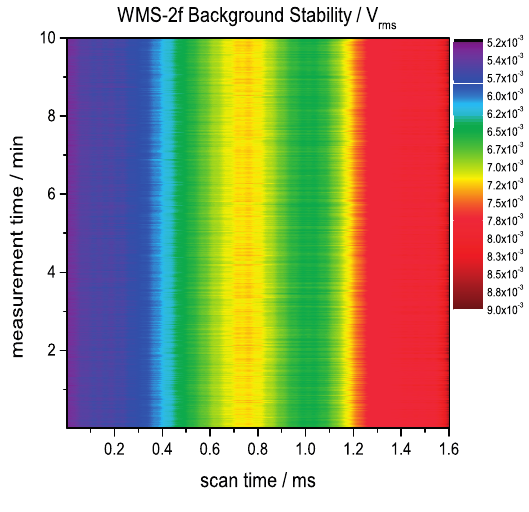
Figure 7. Measured time series of the background caused by RAM. The time series shows a very stable background with minor fluctuation basically caused by electronic noise with a standard deviation of 5.3 × 10 − 5 V rms